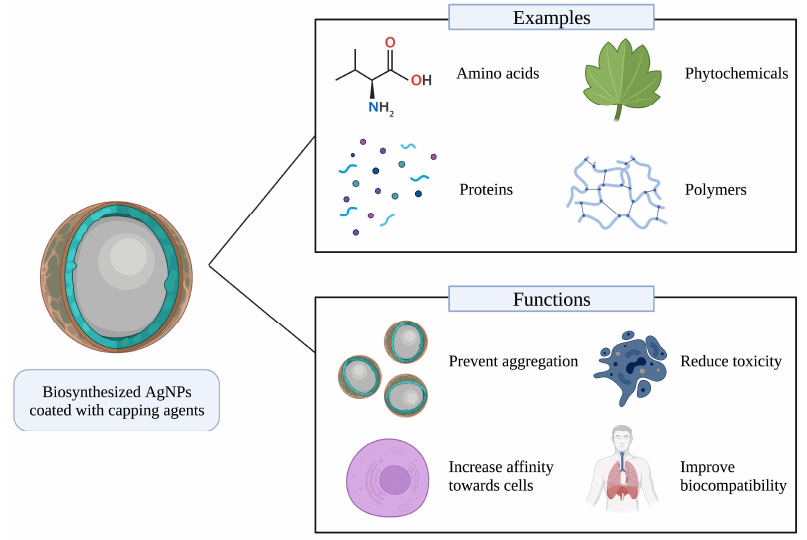
Figure 4. Examples and functions of capping agents in biosynthesized